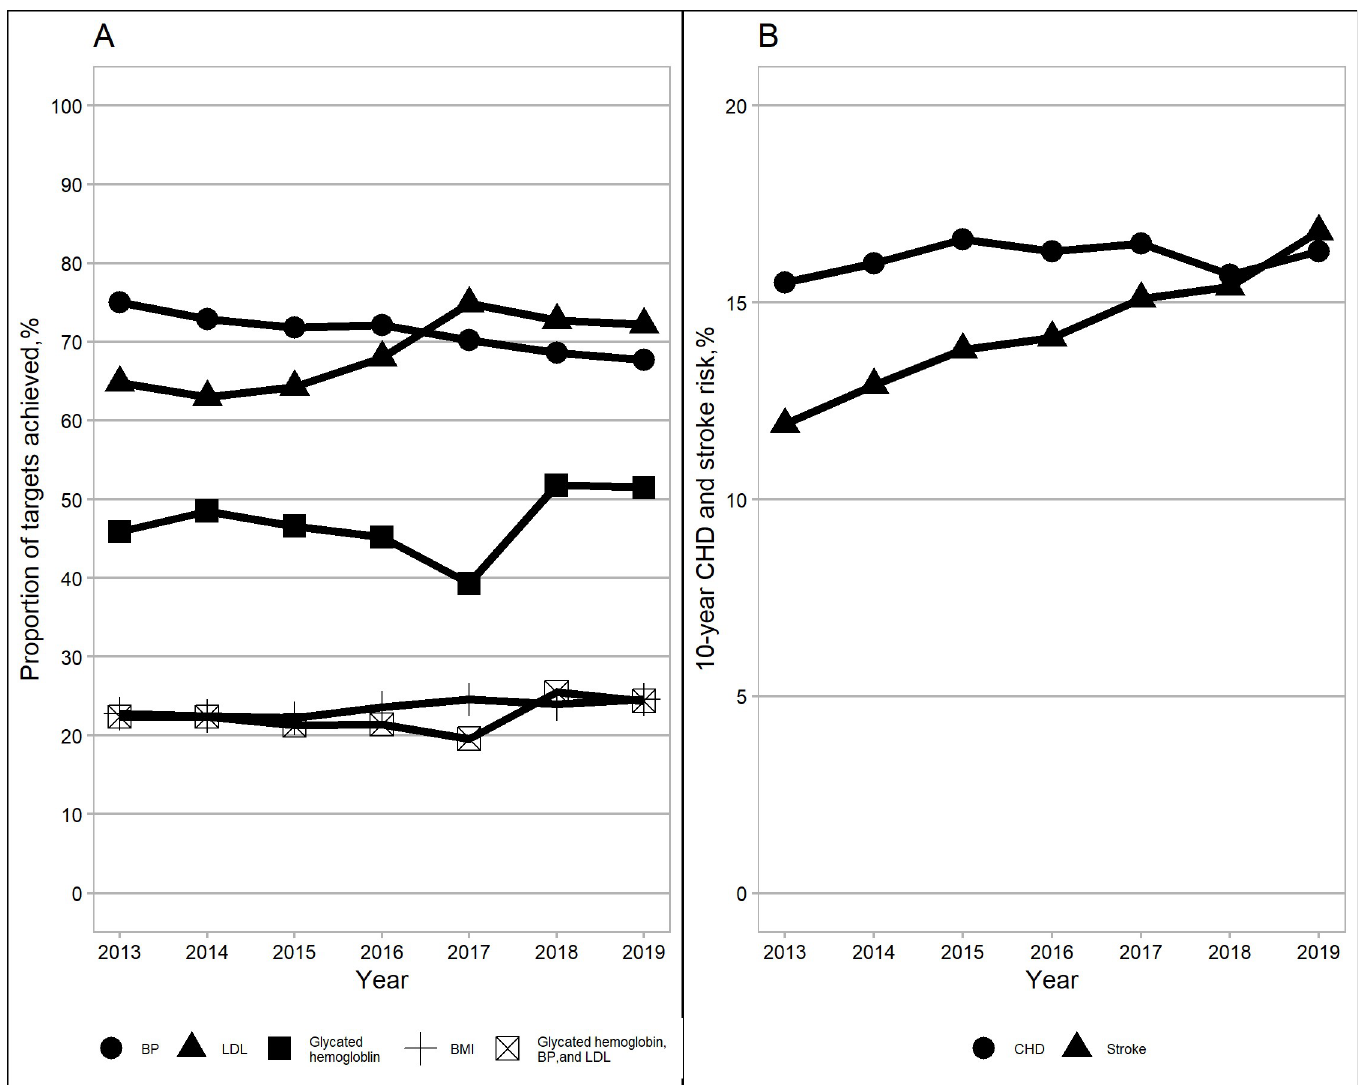
Fig 1. Risk-factor control and 10-year risk for coronary heart disease (CHD) and stroke among patients with diabetes from 2013 to 2019. (A) risk factors included HbA1c ( < 7.0%), blood pressure (BP) (systolic /diastolic BP < 140/90 mmHg), low-density lipoprotein cholesterol (LDL-C) ( < 100 mg/dl), body mass index (BMI) ( < 23 kg/ m 2 ), as well as the combination of HbA1c, BP, and LDL-C. (B) 10-year risk for CHD and